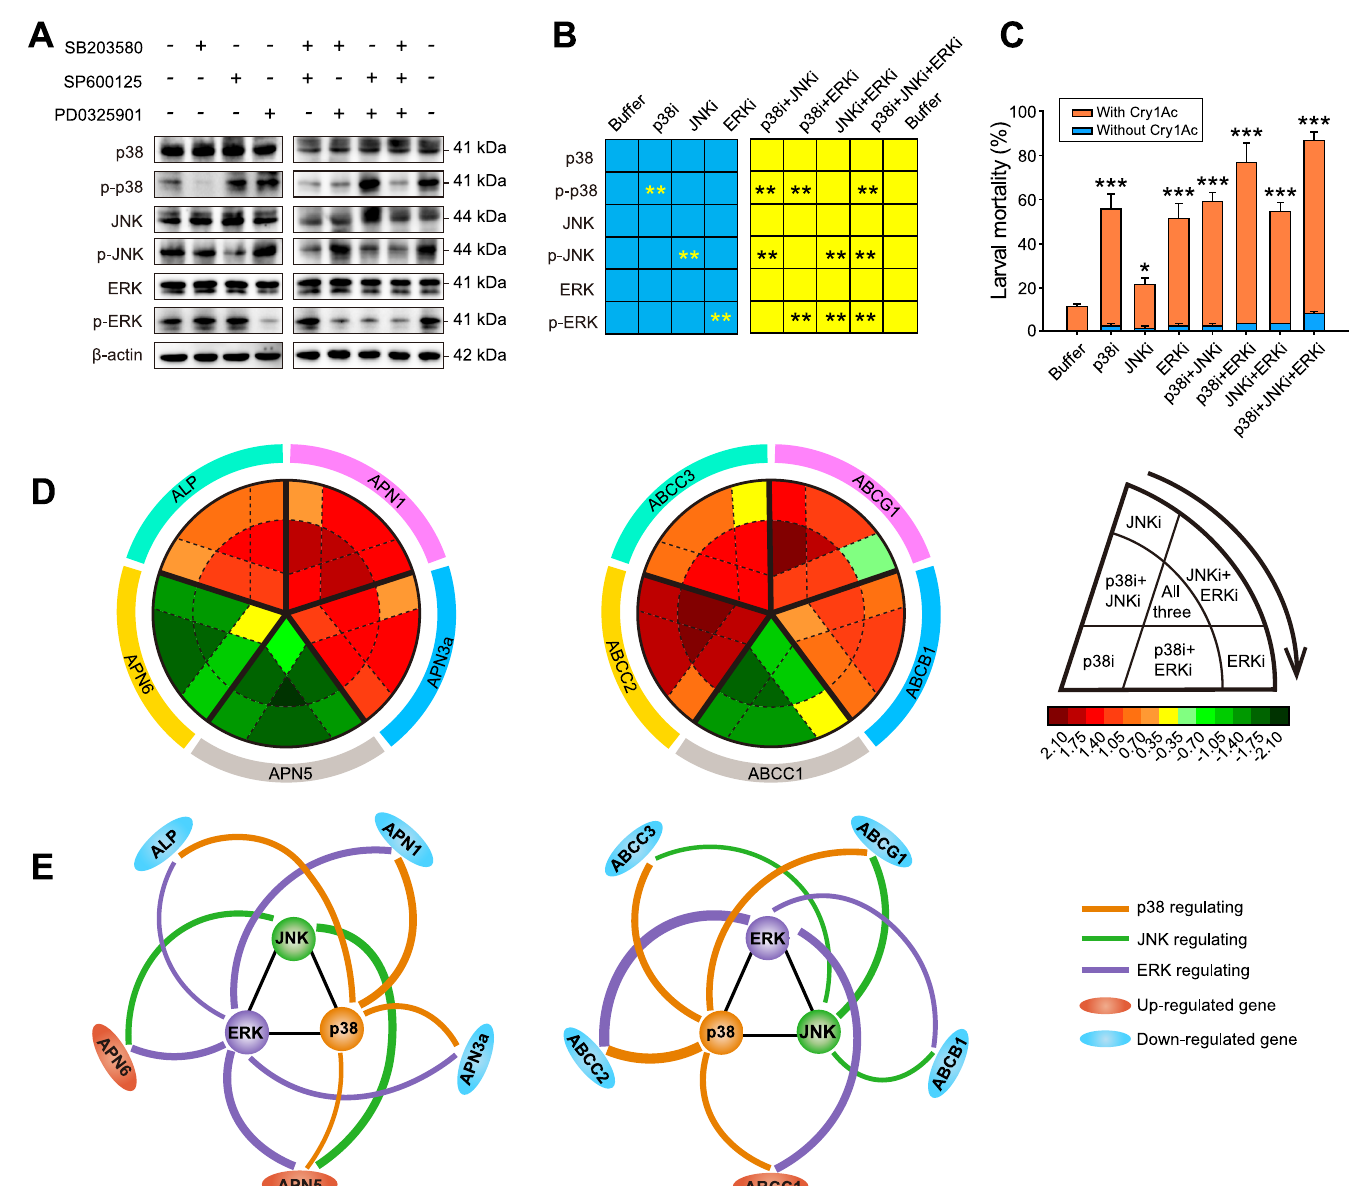
Fig 4. Functional analysis of p38, JNK and ERK MAPK pathways after treatment with specific inhibitors, in Bt Cry1Ac susceptibility of resistant P . xylostella . (A) Western blot analysis of both total protein and protein phosphorylation levels of p38, JNK and ERK in NIL-R larvae pretreated with specific inhibitors. The β -actin protein was analyzed as an internal loading control. (B) The quantification of representative blots (A) using ImageJ 1.51 from three biological replicates. �� P < 0.01 by Duncan’s test compared to the control. (C) Susceptibility to 1000 mg/L Bt Cry1Ac protoxin in NIL-R larvae treated with the different inhibitors. Data in figures are means and standard errors from three biological replicates. � P < 0.05, �� P < 0.01 and ��� P < 0.001 by Duncan’s test compared to the control. (D) qPCR analysis of Cry1Ac resistance-related genes (ALP, APNs and ABC transporters) in midgut tissues of NIL-R larvae pretreated with the indicated inhibitors. The expression levels were transformed to log2 values. All the expression data are from three biological replicates and four technical repeats. (E) Schematic summaries of the regulation effects of p38, JNK and ERK pathways on Cry1Ac resistance-related genes. The thickness of each line is proportional to the strength of the regulation effect. Only regulation effects with significant differences between inhibitor and buffer are shown. The target midgut resistance-related genes with red color indicated that they were up-regulated, while those with blue color indicated that they were down-regulated.